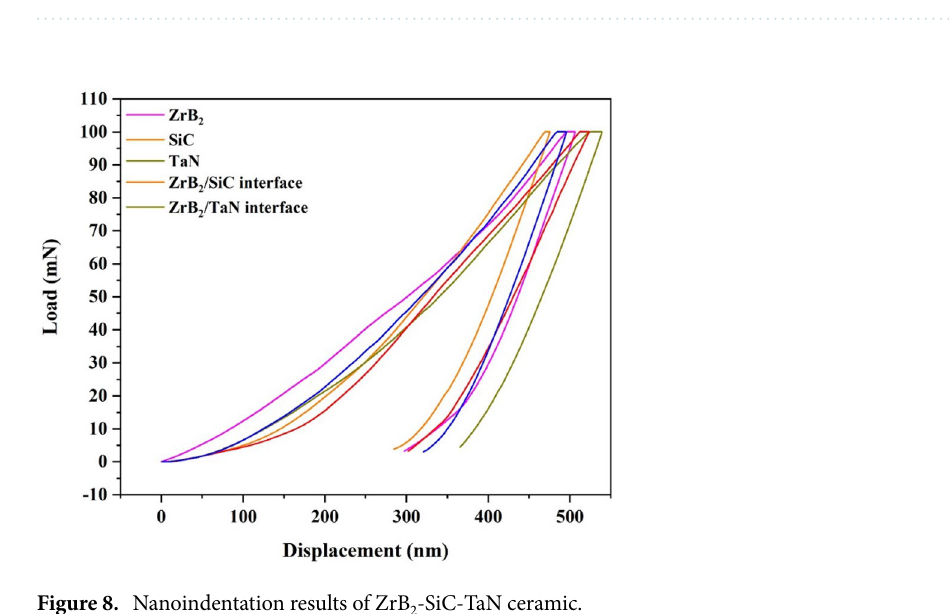
Figure 7. ( a – c ) TEM and HRTEM images of ZrB 2 -SiC-TaN ceramics, and ( d ) the relevant IFFT image.